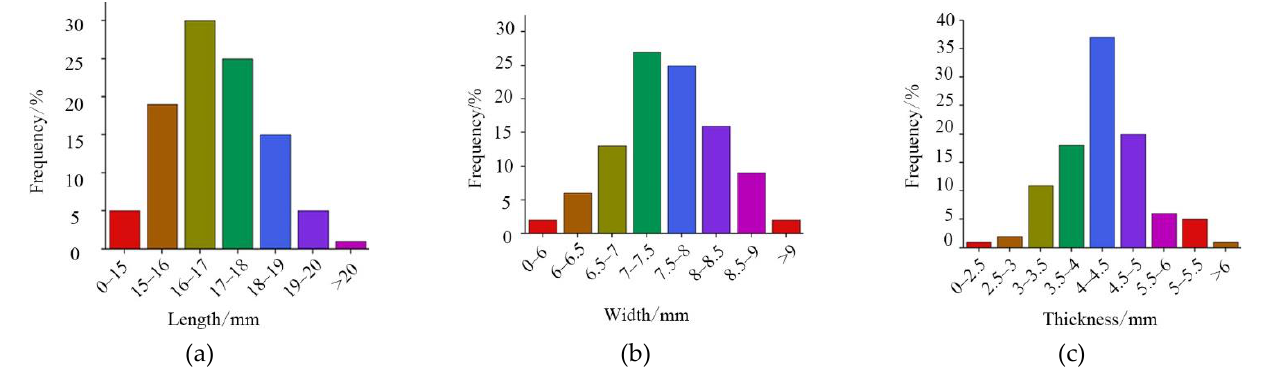
Figure 4. Frequency distribution histogram of seed triaxial measurements. ( a ) Length